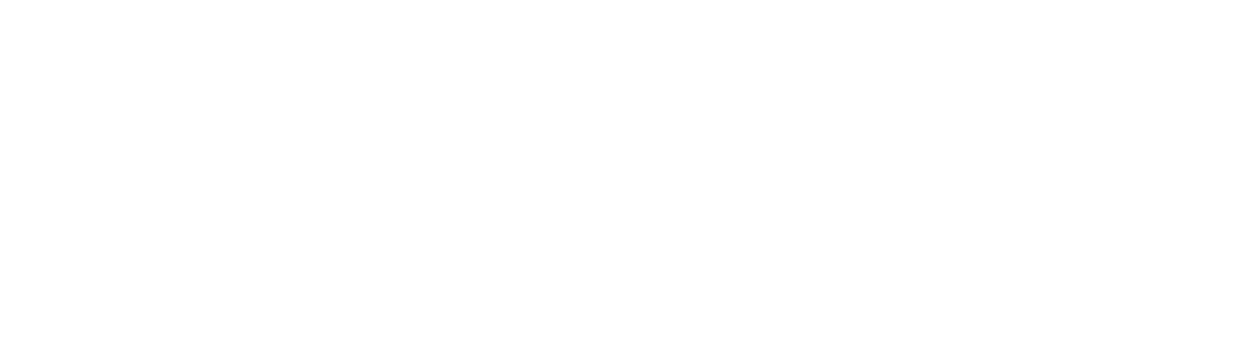
Frontiers in Cardiovascular Medicine |